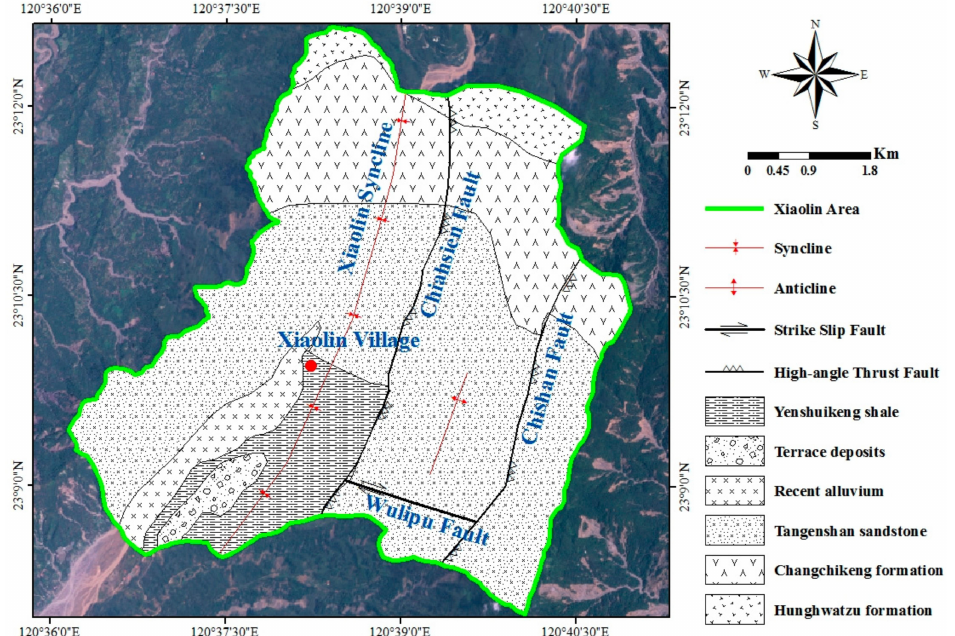
Figure 4. Geological map of the Xiaolin